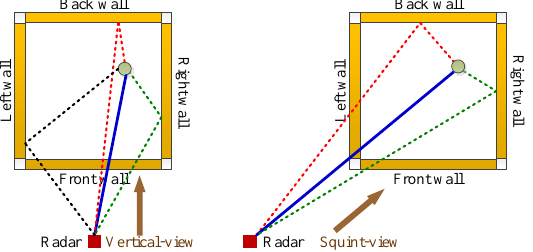
Figure 2. Multi-path propagation model under vertical-view detection and squint-view